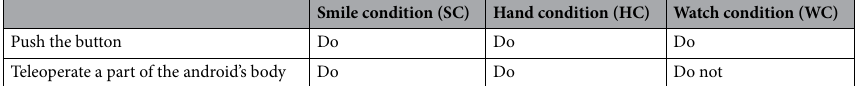
Table 1. Similarities and differences in the behavior of participants in each condition while observing the dialog between the android and its interlocutor. “Do” implies that the participants in each condition followed the instruction written in the leftmost column. “Do not” implies that the participants in each condition did not follow the instruction written in the leftmost column. All participants pushed the button; however, only those in WC did not teleoperate the